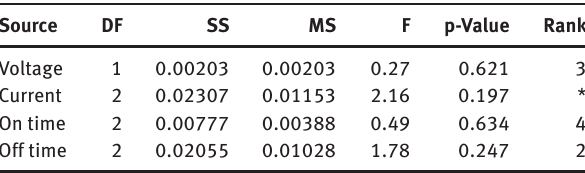
Table 12: Analysis of variance for TWR in the machining of 2024